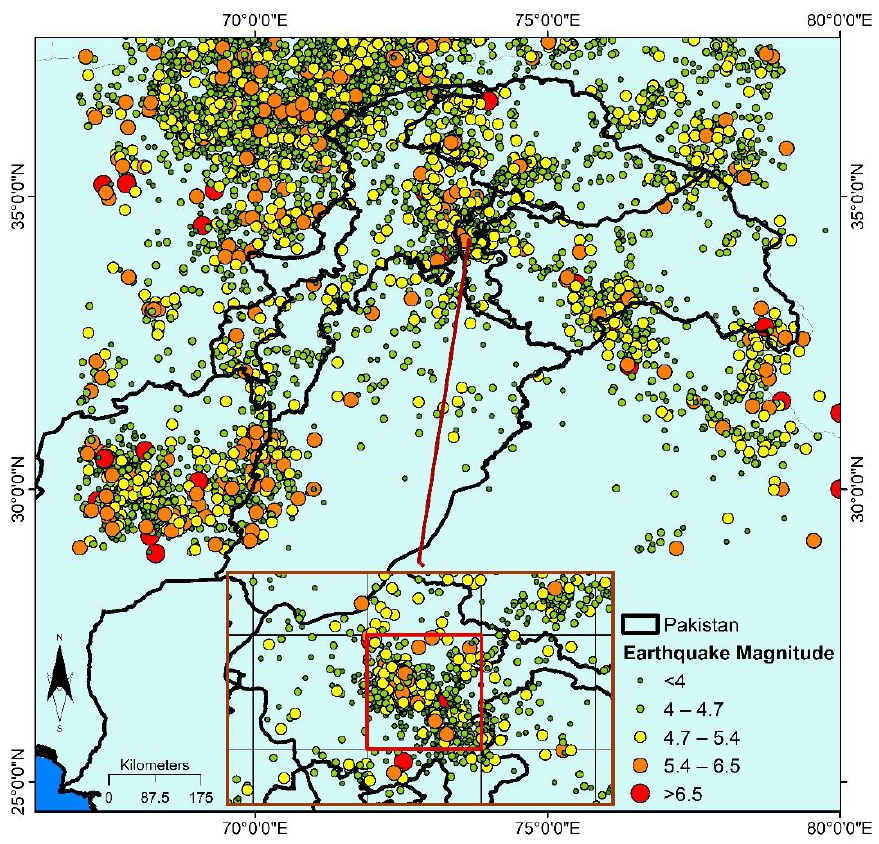
Figure 3. Distribution of earthquakes based on the magnitude of occurrence (greater than 3 Richter) and location from 1970 until 2021 in Pakistan and its surroundings.